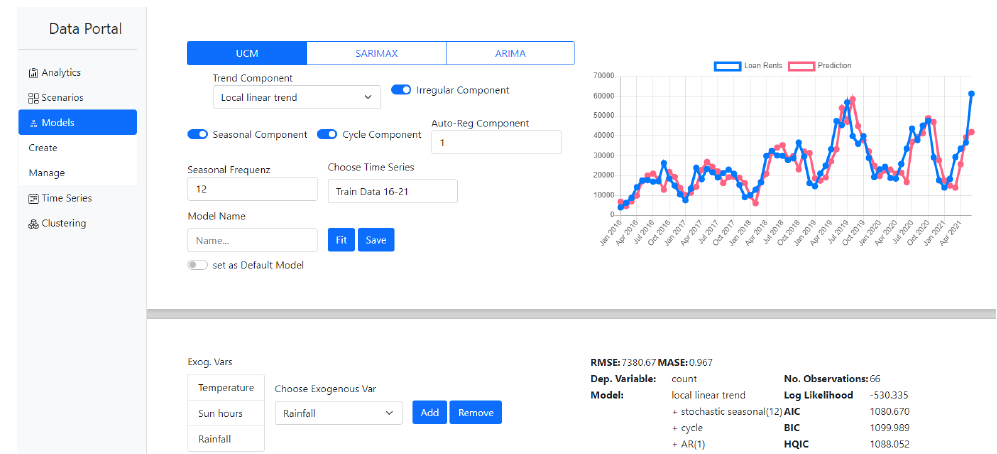
Figure 3. Screen for creating a UCM in the Data Portal. Individual components can be added, modified or removed. Exogenous factors can also be included in the model.